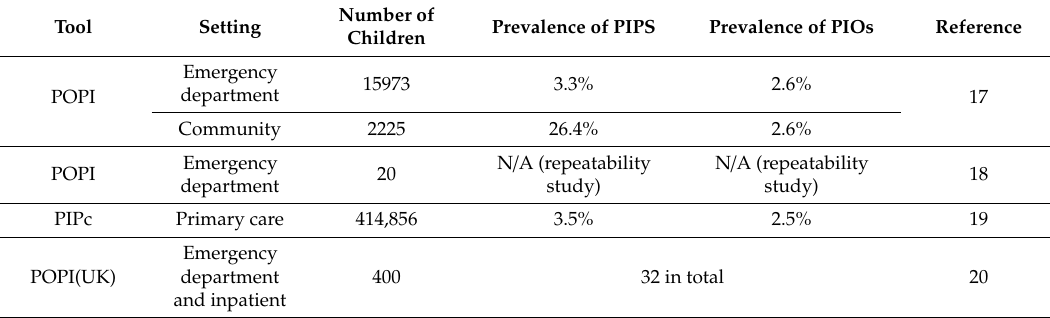
Table 3. Validation or repeatability